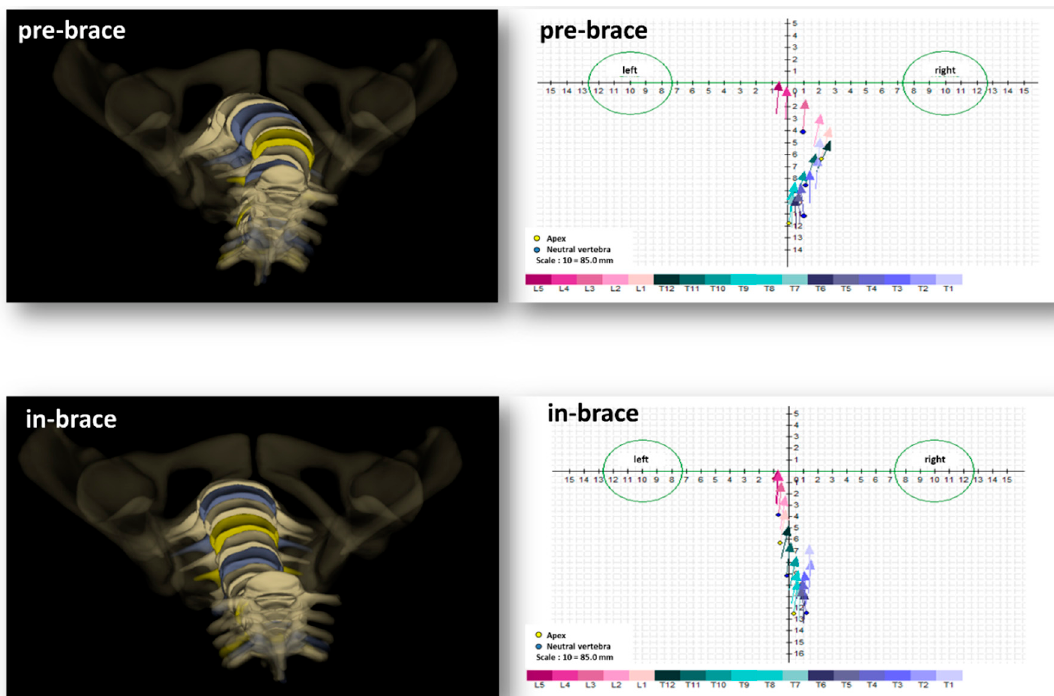
Figure 8. Transverse plane visualizations of the scoliotic spine of the same patient. This figure depicts the in-brace transverse plane changes of a structural thoracolumbar curve (apex L1). The left upper and lower panels illustrate pre- and in-brace 3D reconstructions. The right upper and lower panels illustrate a “top view” of the spine using the vector method as reported by Illes et al. [36]. The two spheres represent the right and left acetabulums. Each vector illustrates the axial rotation of T1–L5.